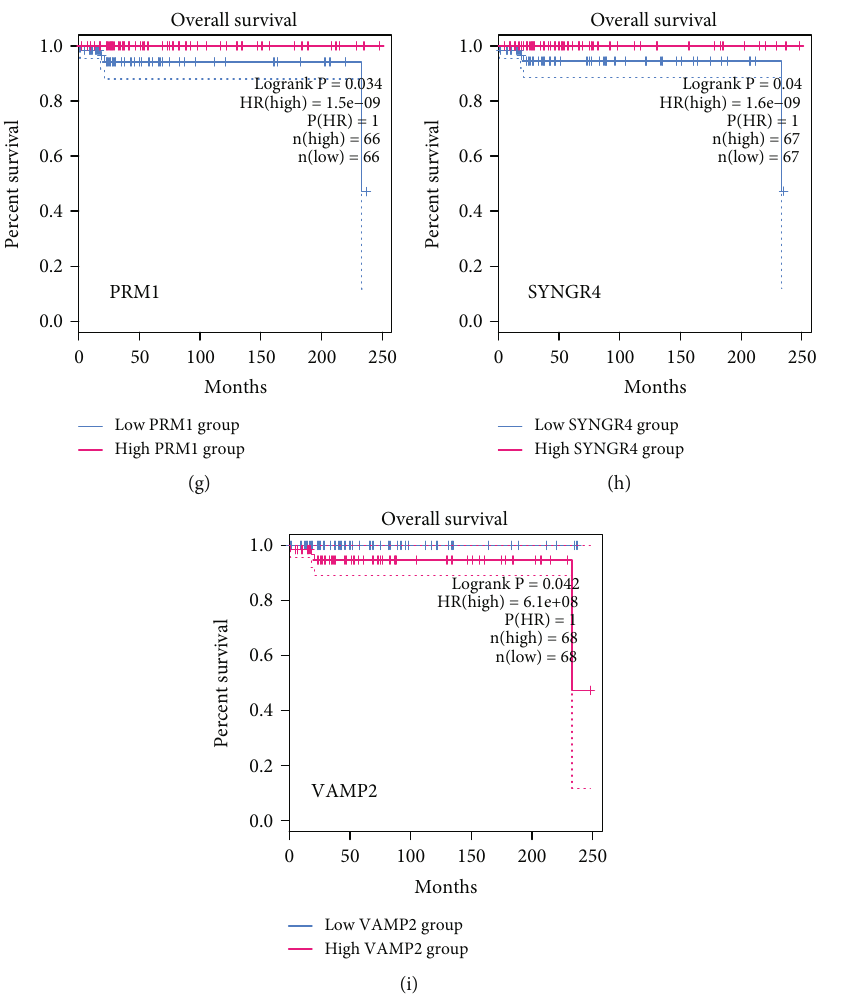
Figure 4: Survival plots for the nine risk-related genes. (a – i) FNDC8, FSCN3, GLB1L, GSTA1, LAPTM5, MAMLD1, PRM1, SYNGR4, and VAMP2, respectively. Red represents the high gene expression group, and blue represents the low gene expression group. P values are